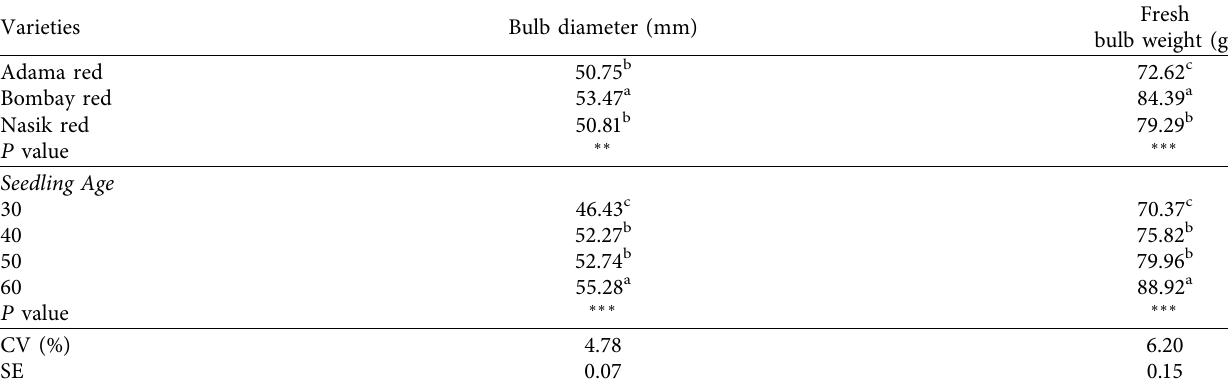
Table 4: Efect of variety and seedling age on yield parameters of